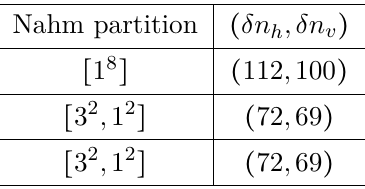
Table 6. Table containing the data defining the punctures for the 4d E 6 × E 6